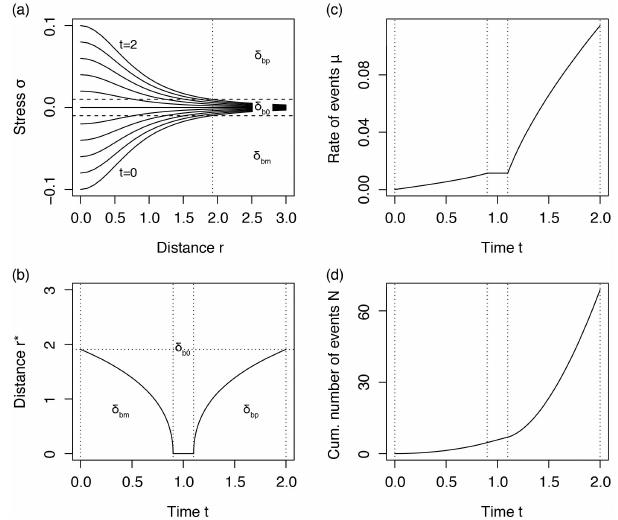
Figure 1. Seismicity spatio-temporal behaviour described by the N-C PAST static stress model (tectonic case; Mignan, 2012): (a) spatio-temporal evolution of the stress field σ(r,t) generated by constant stress accumulation ˙ τ on a fault located at r = 0 (Eq. 1). Background, quiescence, and activation seismicity regimes are de- ± (cid:49)σ ∗ , scribed by densities of events δ b0 , δ bm , and δ bp for | σ | ≤ σ ∗ 0 − (cid:49)σ ∗ , and σ > σ ∗ + (cid:49)σ ∗ , respectively; (b) temporal evo- σ < σ ∗ 0 0 lution of quiescence and activation envelopes r ∗ (t) , with σ (cid:0) r ∗ (cid:1) = ± (cid:49)σ ∗ (Eq. 2); (c) rate of events µ(t) in a disc of constant radius σ ∗ 0 max (cid:0) r ∗ (cid:1) (Eq. 3); (d) cumulative number of events N(t) (Eq. 4) of power law form (Eq. 5), with t 0 = 0, t mid = 1, t f = 2, h = 1, ˙ τ = 0.1, = 0, (cid:49)σ ∗ = 10 − 2 , δ = 0.001, δ = 0.1, δ = 1, n = 3, k = σ ∗ bm b0 bp 0 π , d = 2, (cid:49)t =